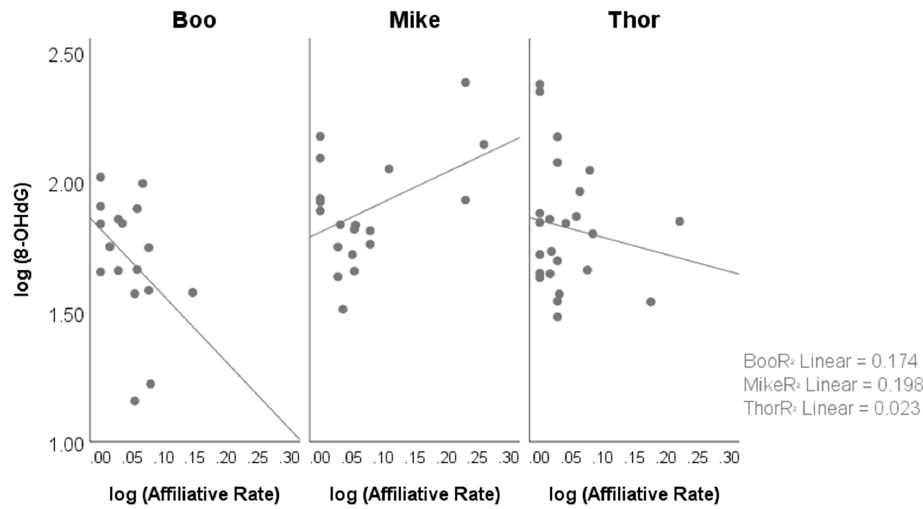
Figure 4. Scatterplots showing log-transformed rates of affiliative interactions as a predictor of log-transformed fecal oxidized guanine (8-OHdG) concentrations (ng/g) for three male grizzly bears.